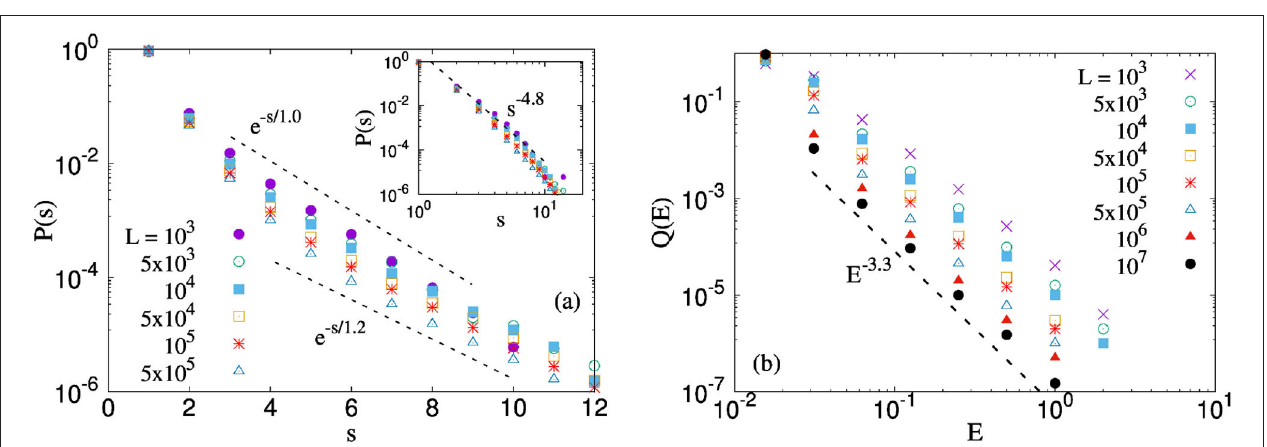
FIGURE 3 | Distribution of energies for an uniform distribution (0,1) and system sizes ranging in between 10 3 and 10 5 . The results are shown for GLS FBM. (a) We already know that in the mean-field limit P ( s ) ∼ s − β , with β ≈ 2.5. (b) We observe Q ( E ) ∼ E − α where α ≈ 2.5 as well independent of the system size.